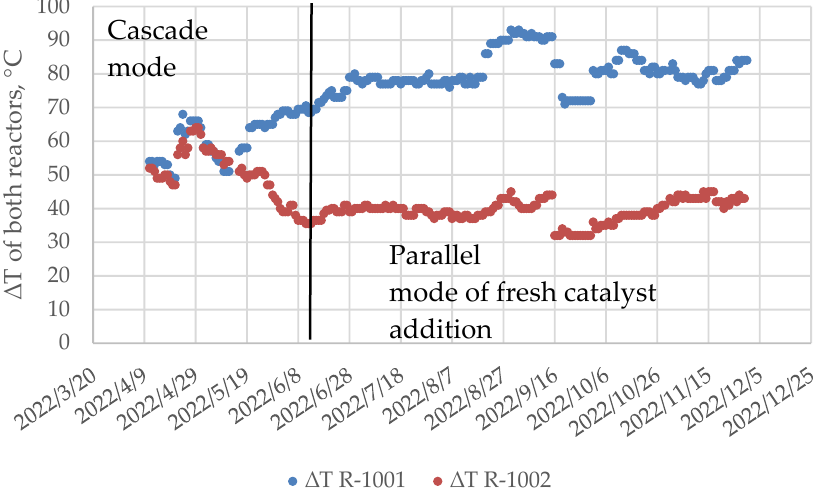
Figure 9. Variation of ∆ T of both ebullated bed reactors during the investigated period .